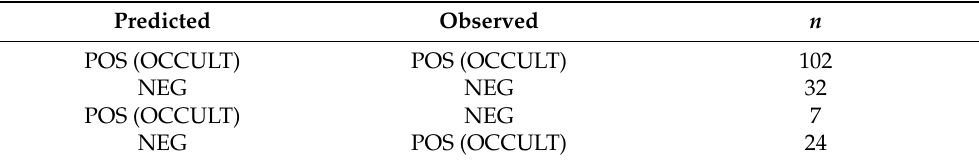
Table 8. Contingency table, counting all combinations of the predicted versus observed. Predicted indicates class predicted by the model; observed indicates class as graded on FA; and n indicates the number of